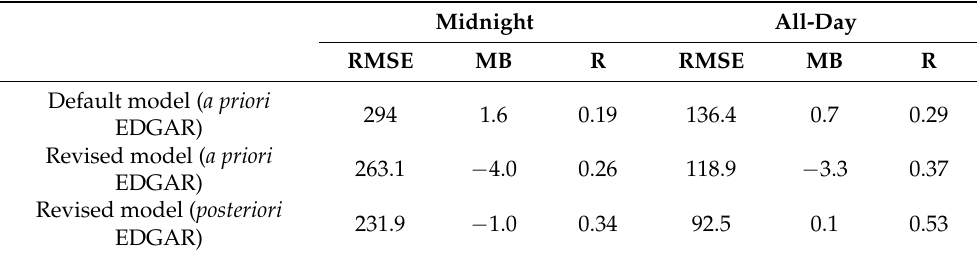
Table 3. Statistics for different simulation cases for daily CO 2 during midnight and